Question: What kind of plot is shown here?
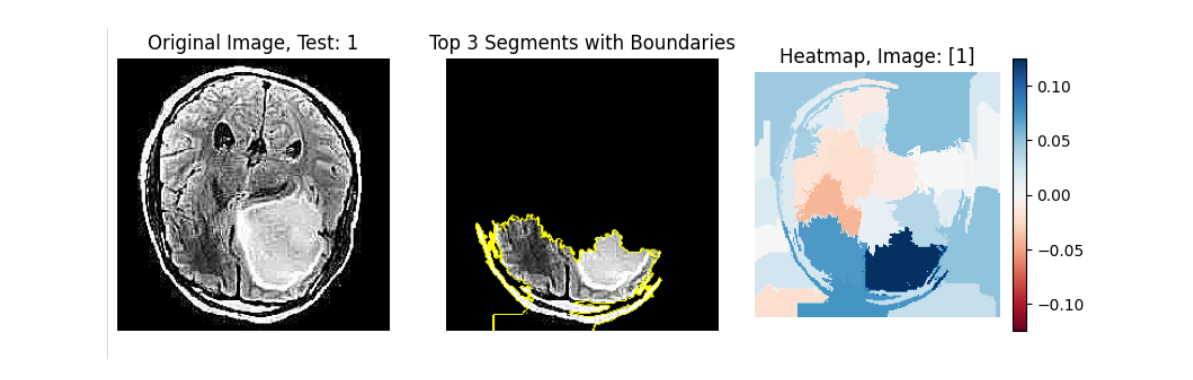
Answer: heatmap